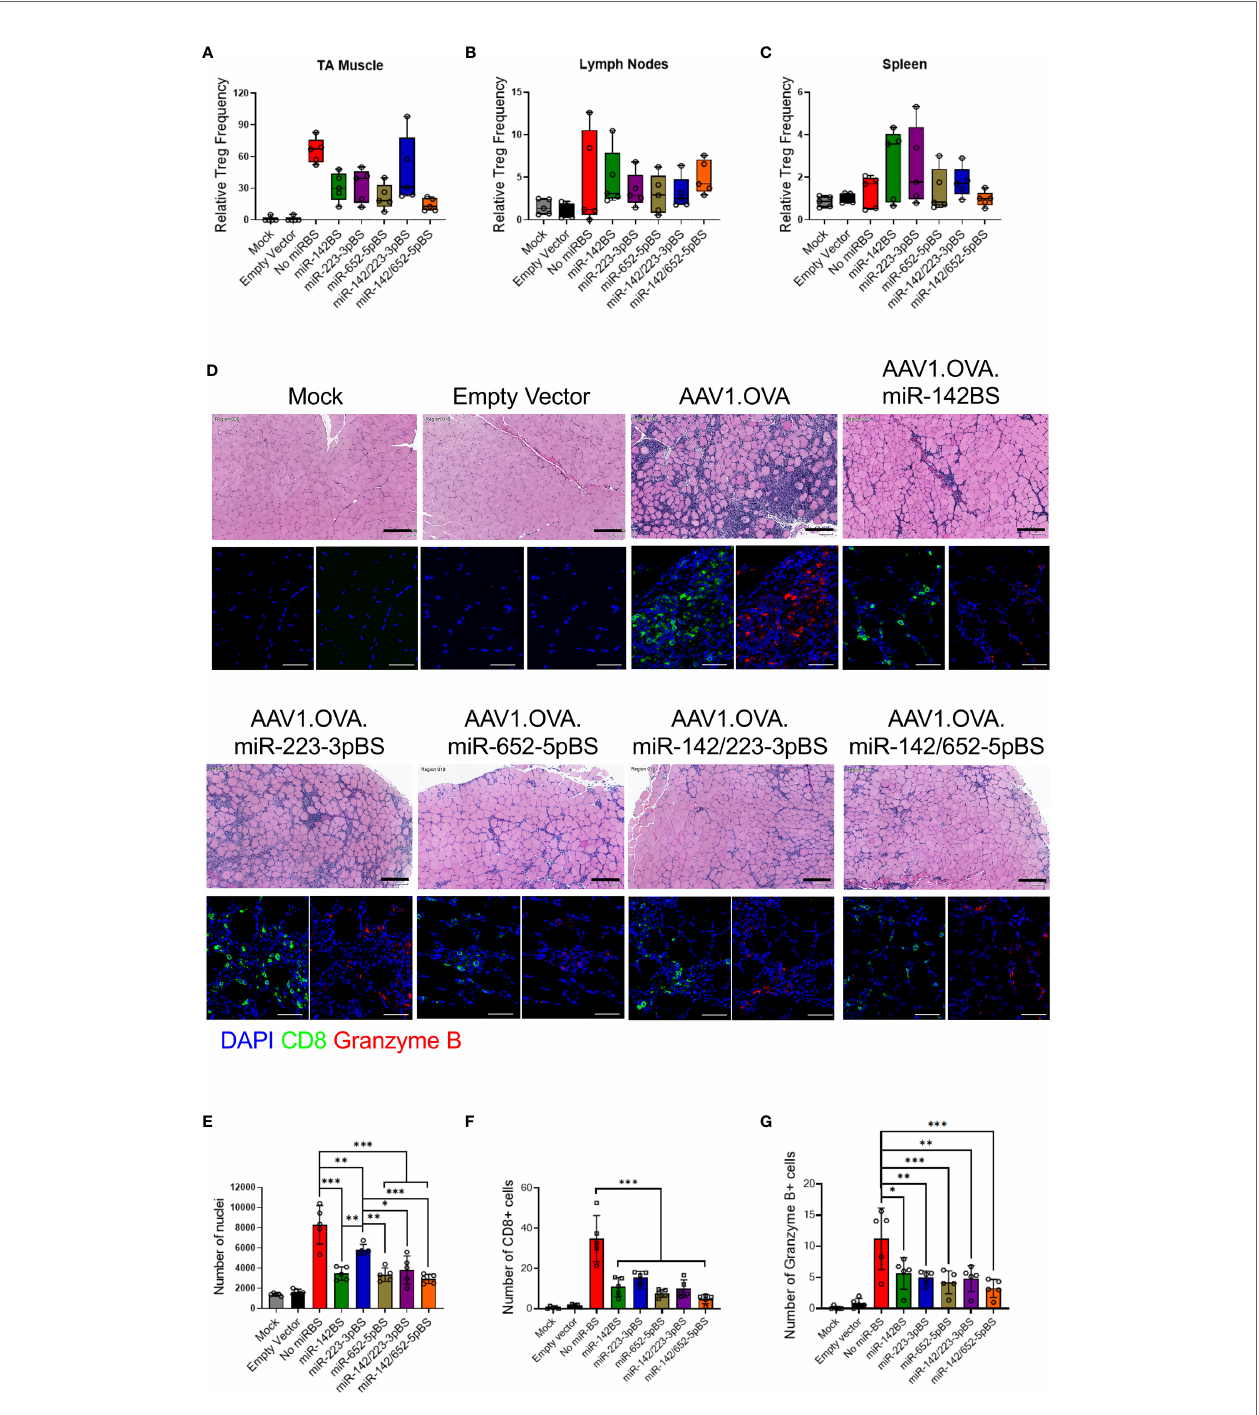
FIGURE 6 | miRNA-mediated detargeting acts independent of Treg immunosuppression and reduces tissue clearance by downregulation of OVA-speci fi c CTL response. (A – C) Cells from TA muscle, lymph nodes and spleen were harvested from rAAV1 injected C57BL/6 mice four weeks after treatment and stained for Treg markers (CD4+, CD25+, FOXP3+). The frequencies of Tregs were quanti fi ed by fl ow cytometry and displayed as box and whisker plots ( n = 5). (D) C57BL/6 male mice, six weeks old, were i.m. injected with rAAV1.OVA vectors with or without miRBS (1 × 10 11 GCs/mouse, n = 5) and sacri fi ced two weeks after injection to harvest muscles. Tissue sections were stained for H&E (upper panels, original magni fi cation: 20x), CD8 and granzyme B (lower panels: DAPI, blue; red, granzyme B, red; and CD8, green; original magni fi cation: 40x). Scale bars = 200 m m (H&E images), 50 m m ( fl uorescence images). (E) Quanti fi cation of H&E images for nuclear in fi ltrates in whole tissue section at original magni fi cation of ×20. (F, G) Quanti fi cation of CD8 (F) and granzyme B (G) images in four fi elds at original magni fi cation of 40x. p values were estimated by one-way ANOVA with Tukey ’ s post hoc test. * p < 0.05, ** p < 0.01, *** p <